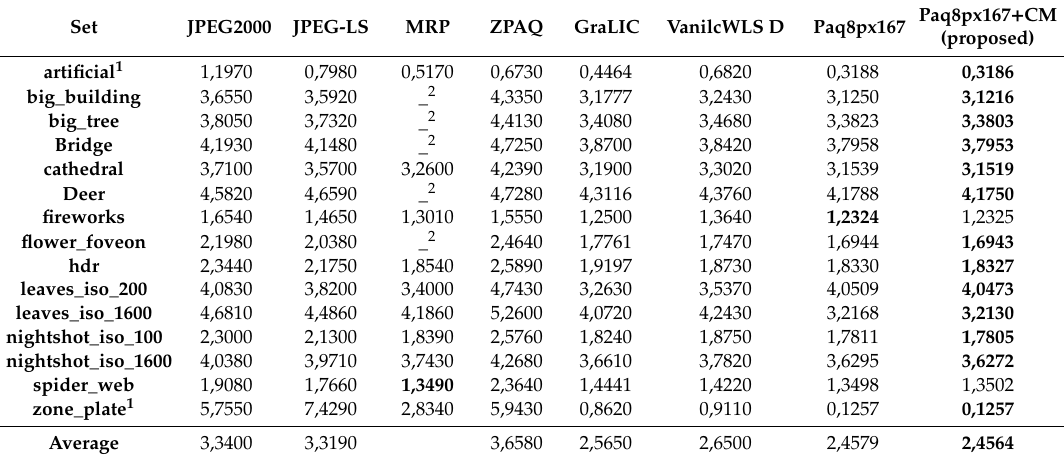
Table 3. Imagecompression.info 8 bpp gray new test